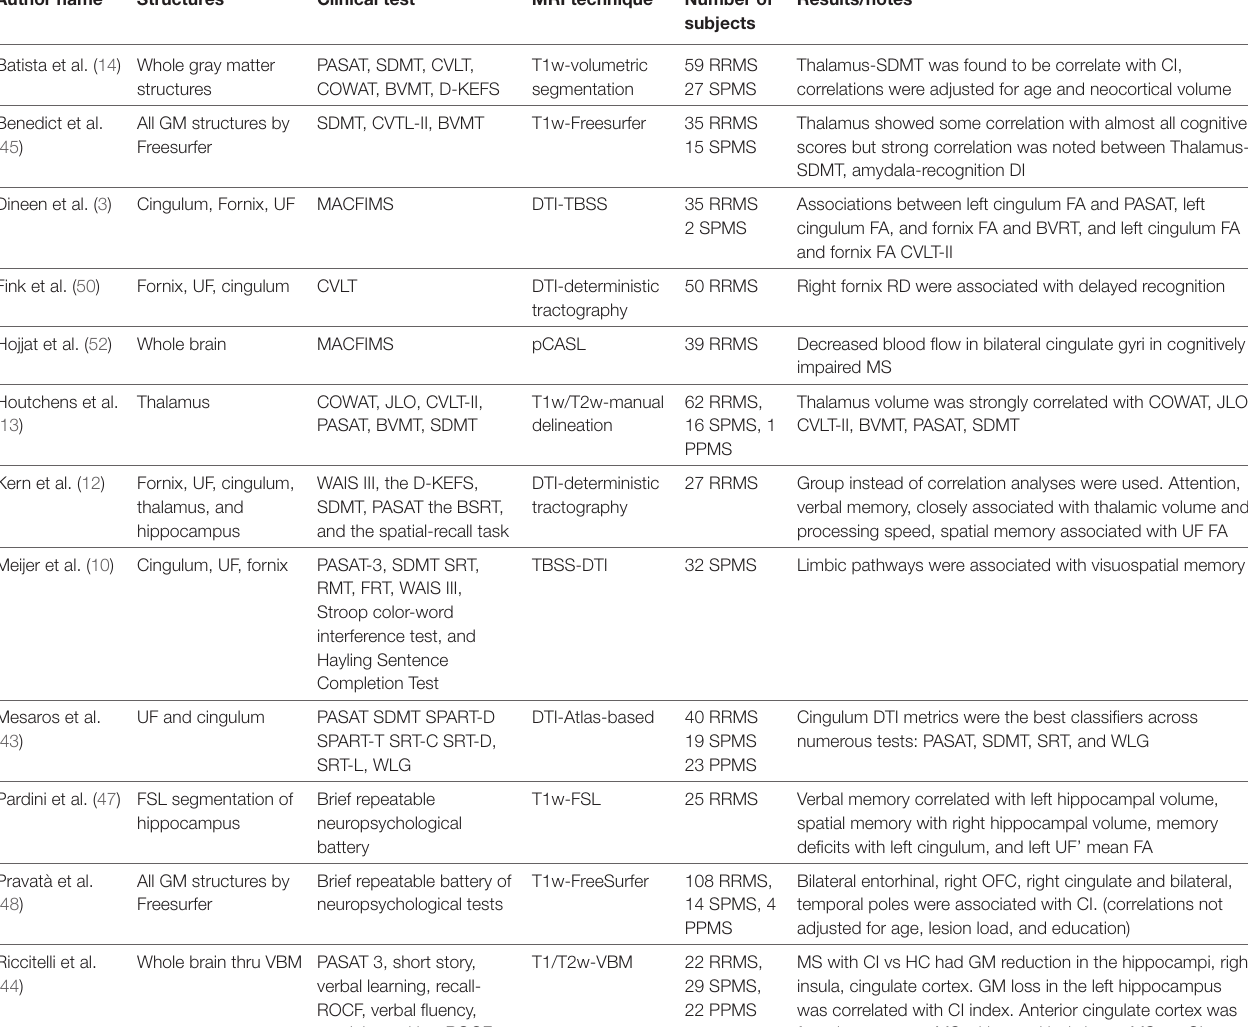
TaBle 1 | Tabulated summary of key MRI studies investigating limbic structures in multiple sclerosis